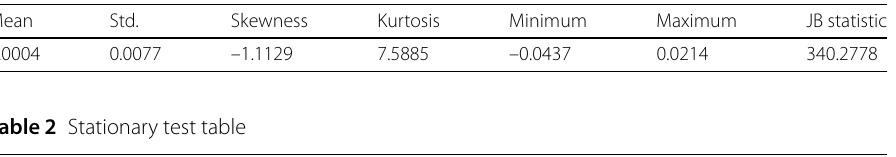
Table 1 Main digital feature of CSI 300 index